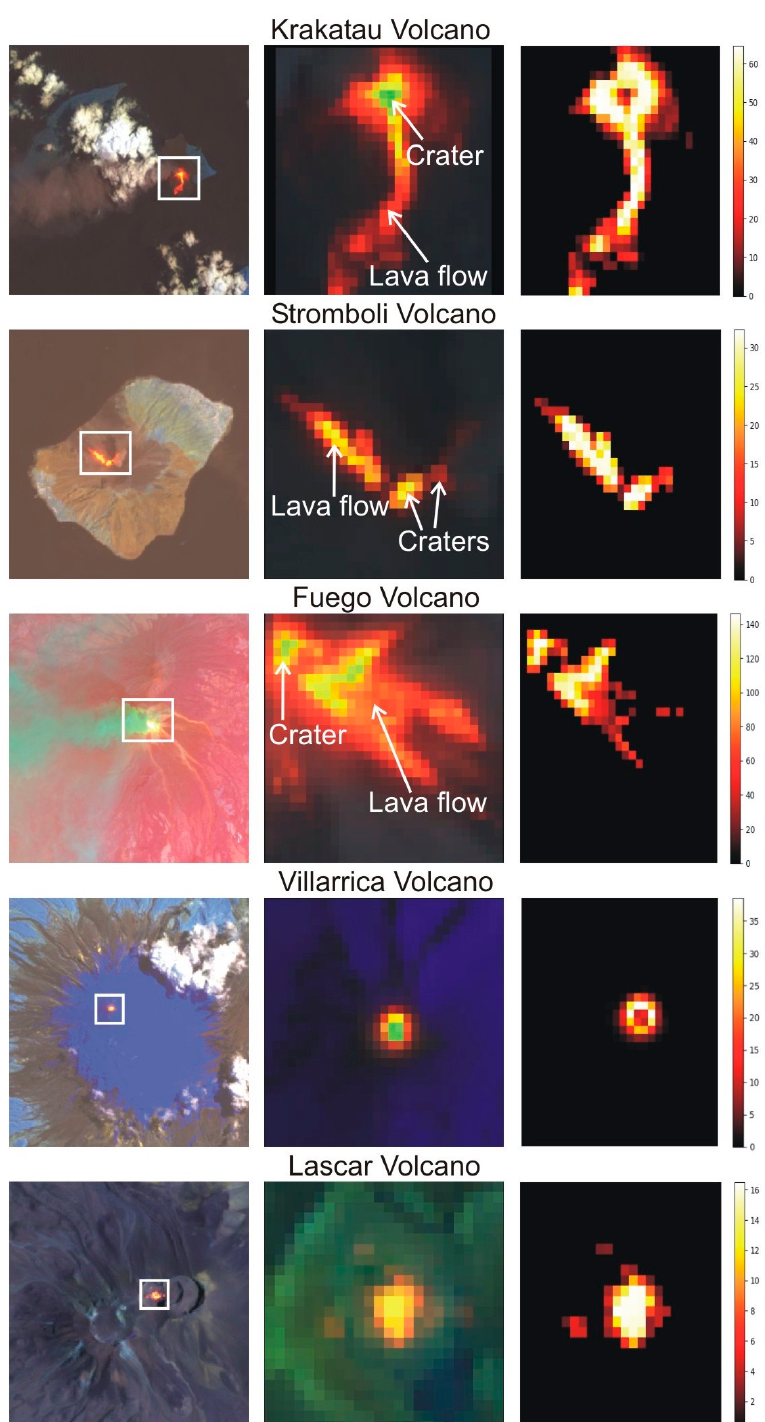
Figure 6. Krakatau Volcano: Landsat OLI image of (1 October 2018), RGB false color composite band 7-6-5 and processed SWIR2 band, respectively. Stromboli Volcano: Landsat OLI image (8 August 2019), RGB false color composite band 7-6-5 and processed SWIR2 band, respectively. Fuego Volcano: Landsat OLI image (1 February 2018), RGB false color composite band 7-6-5 and processed SWIR2 band, respectively. Villarrica Volcano: Landsat OLI image (6 February 2015), RGB false color composite band 7-6-5 and processed SWIR2 band, respectively. Lascar Volcano: Landsat TM image (14 December 1989), RGB false color composite band 7-5-4 and processed SWIR2 band, respectively. White boxes indicate the area shown in the second and third rows.